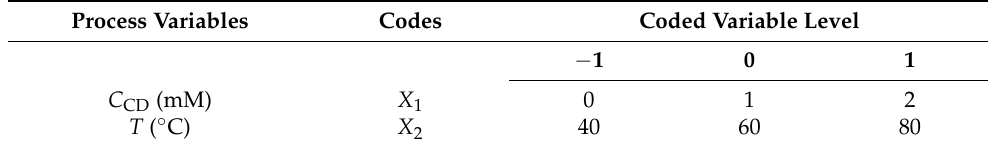
Table 1. Codified and actual values of the process variables employed to construct the experimen- tal